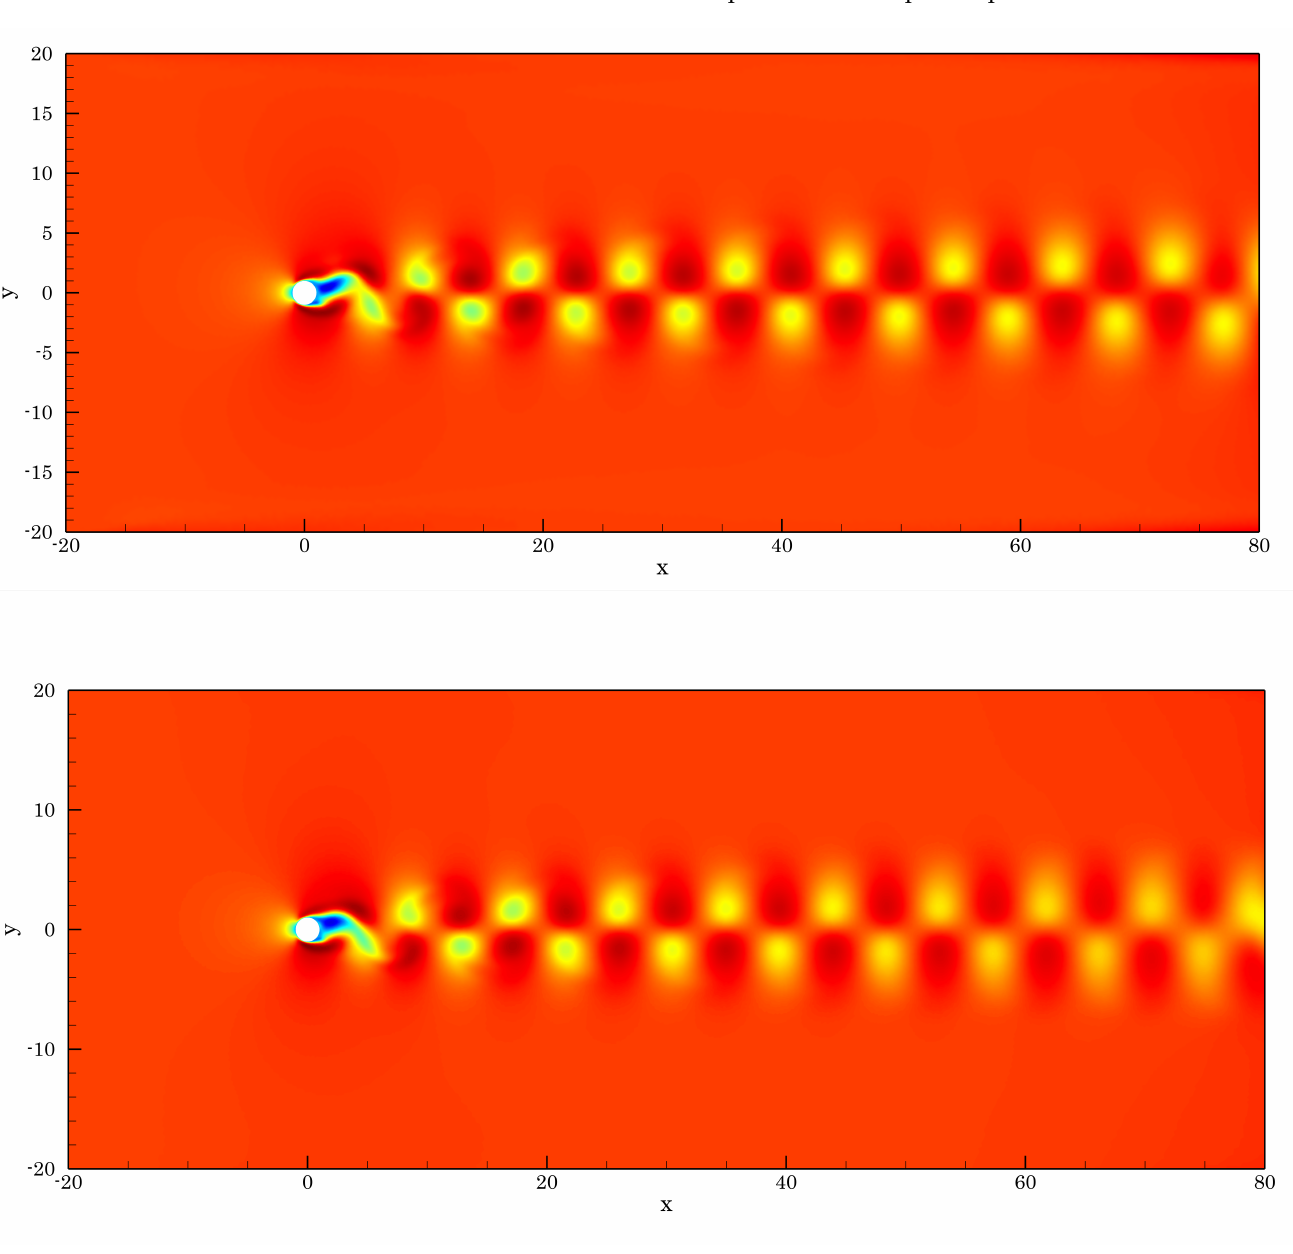
Figure 8. Von Kármán vortex street for an incompresible flow around a cylinder at time t = 250 for a fluid with power-law index n = 1.5 without yield stress ( top ) and with yield stress σ y = 10 − 3 ( bottom ). The contour plots correspond to the horizontal